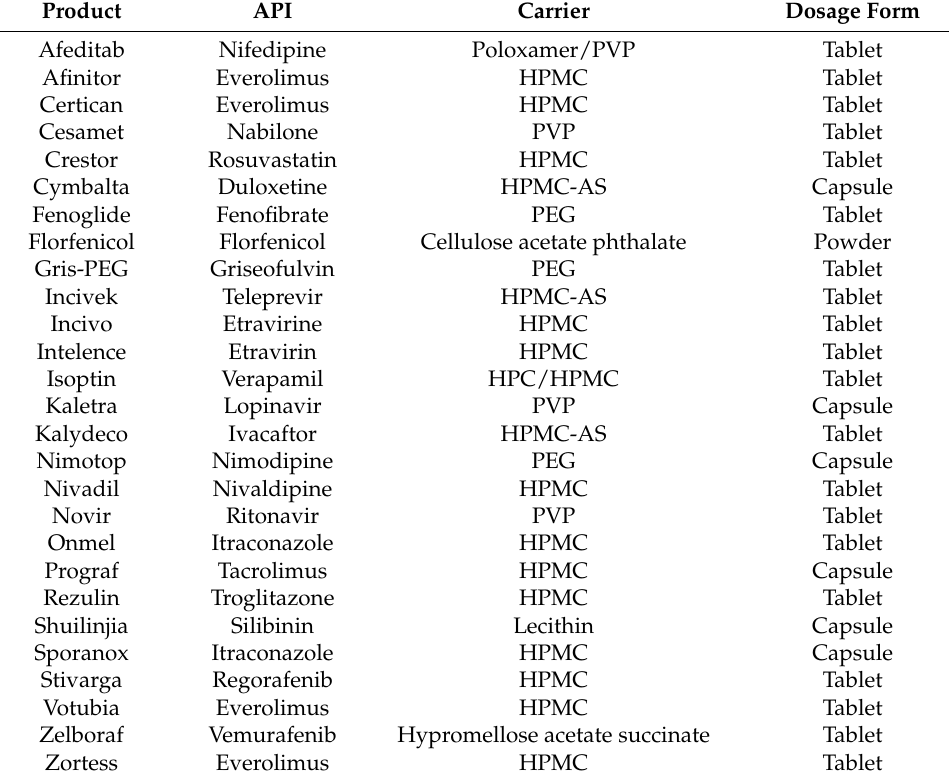
Table 1. Summary of commercially available ASD